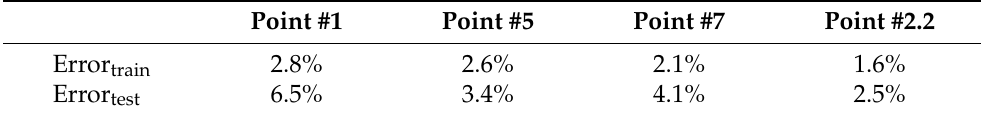
Table 3. Relative errors of time evolution using sPGD model.